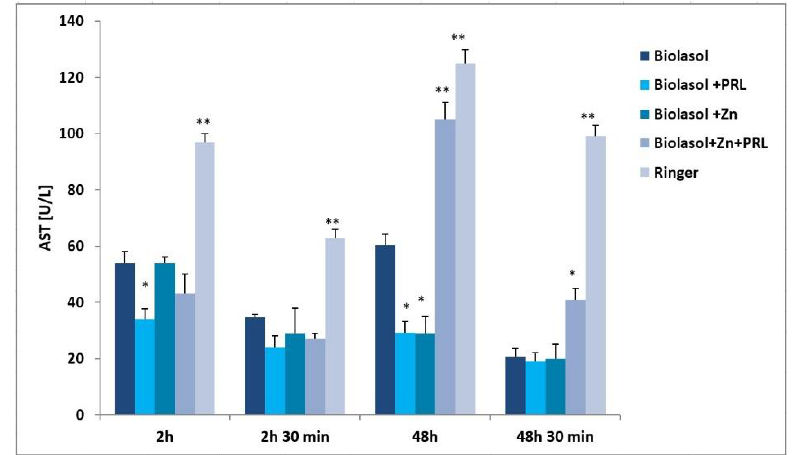
Figure 2. AST activity in the collected perfusates and reperfusates in model of storing isolated porcine kidneys. The values are expressed as mean ± SEM. Data were analysed by one-way ANOVA and Bonferroni post hoc tests; n = 10; * p < 0.05; ** p < 0.01 compared to the control group (Biolasol).